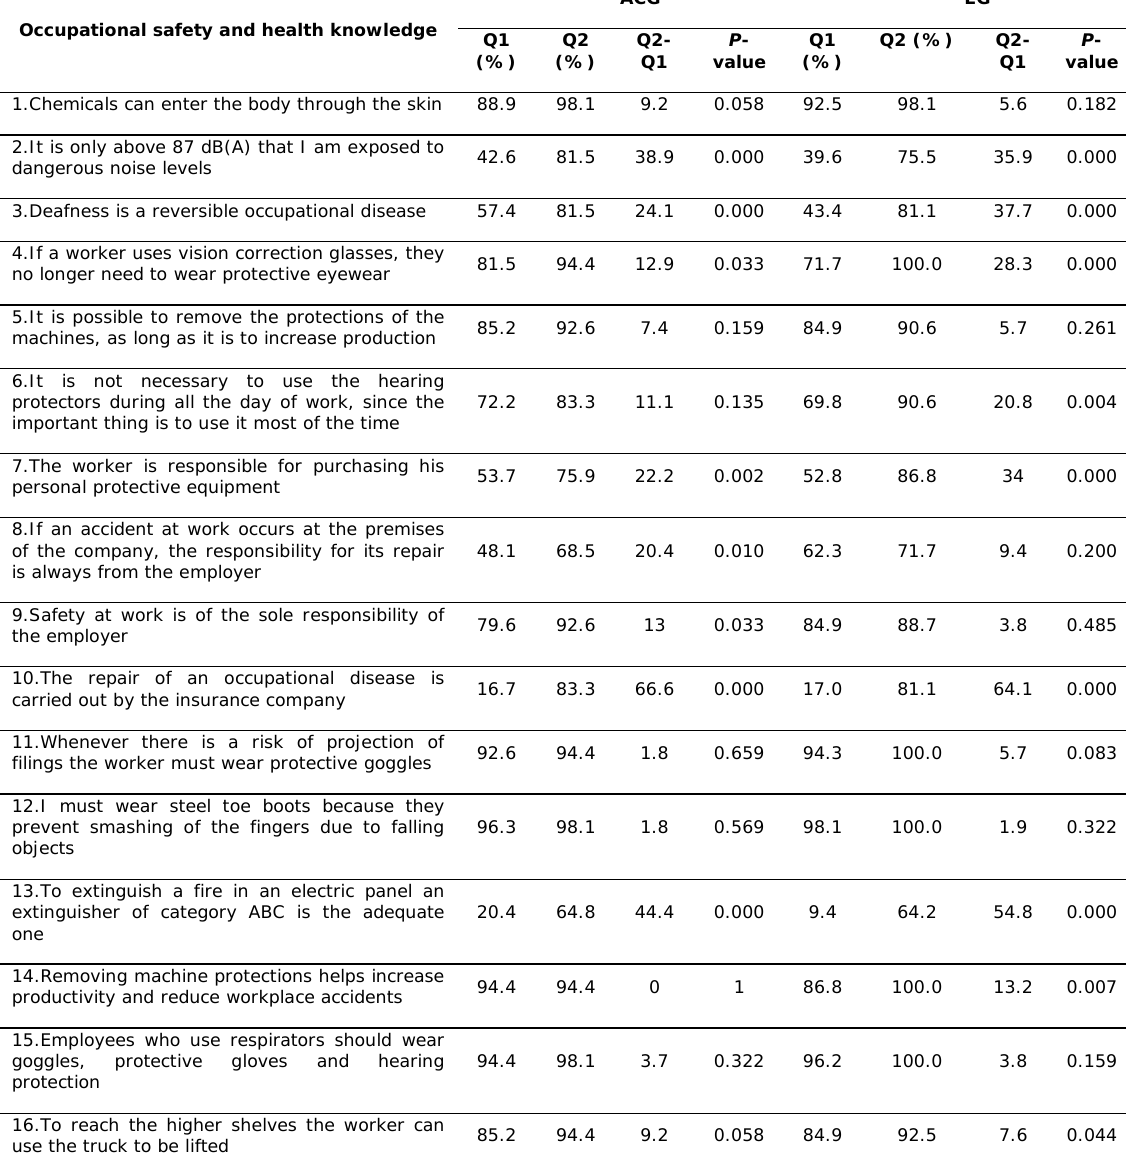
Table 3. Level of knowledge in percentage of correct answers, by intervention